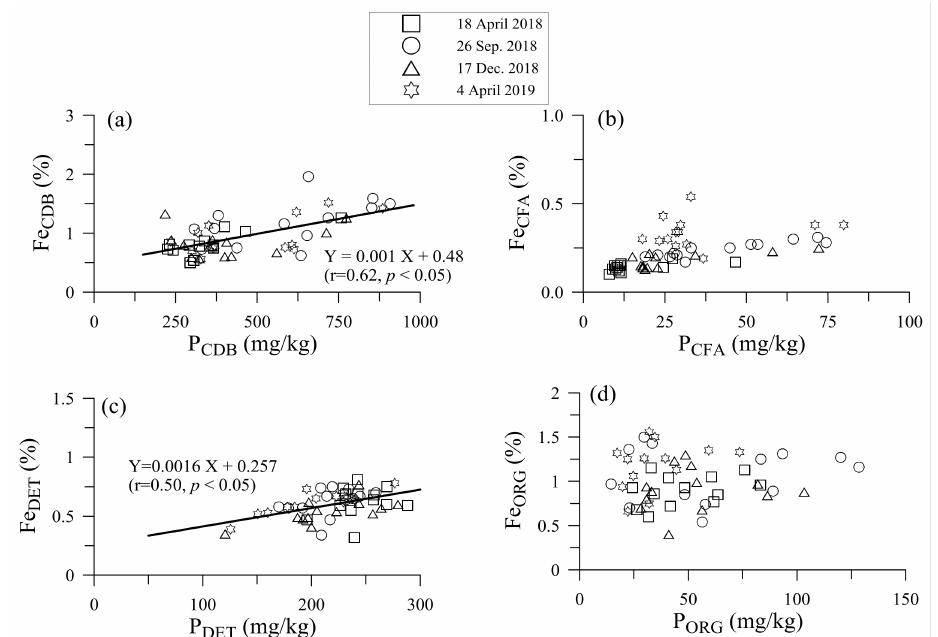
Figure 11. Scatter plots of the four fractions P and Fe concentrations in the DRE surface sediments ( a ) P CDB against Fe CDB , ( b ) P CFA against Fe CFA , ( c ) P DET against Fe DET , and ( d ) P ORG against Fe ORG